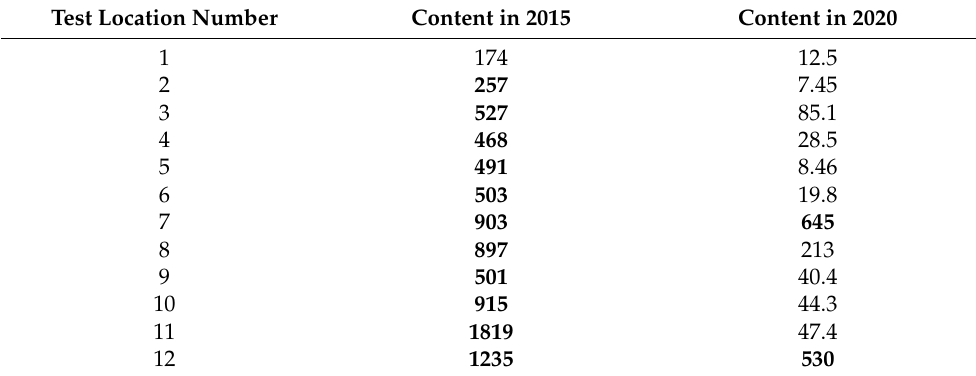
Table 6. Changes in total PAH content (mg kg − 1 DM) in the soil before (2015) and after enhanced natural attenuation (2020).